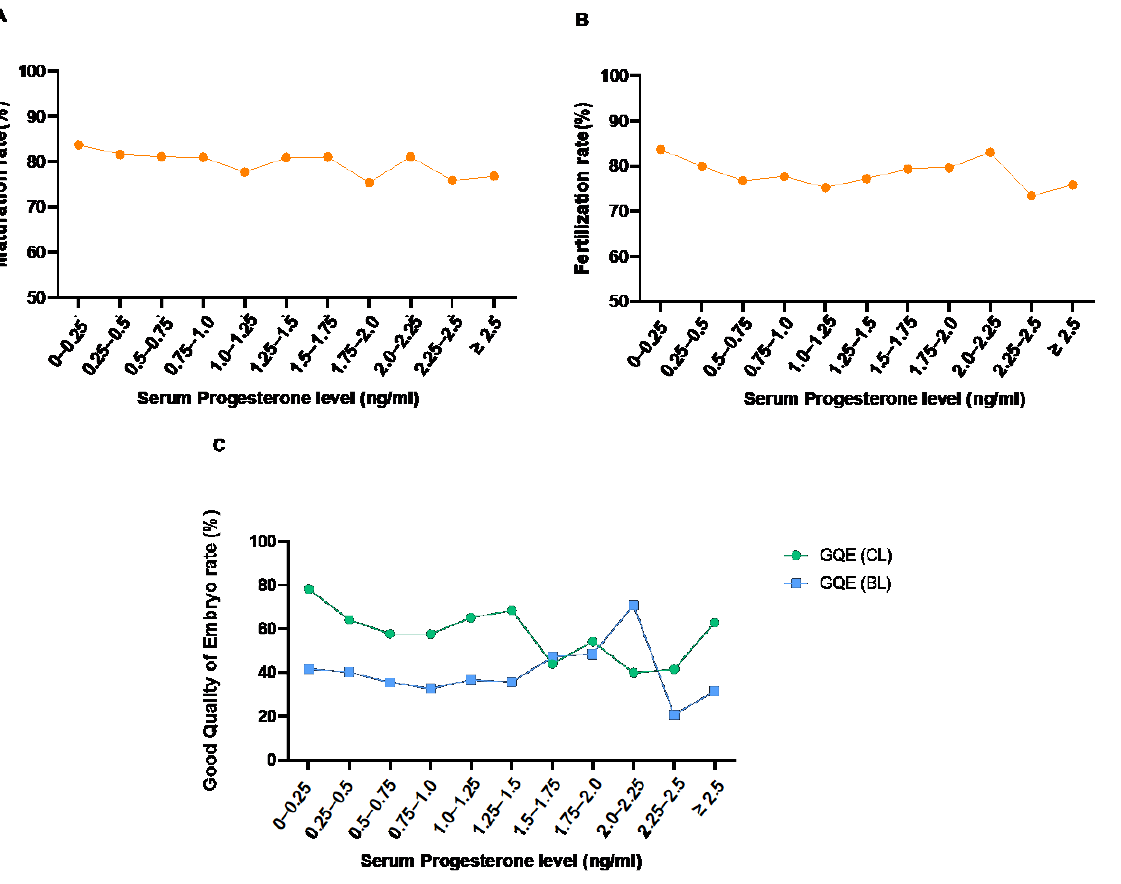
Figure 1. Association between the levels of serum progesterone on the day of hCG admin-istration and maturation rate ( A ), fertilization rate ( B ), and good-quality embryo (GQE) rate (cleavage stage (CL) and blastocyst stage (BL)) ( C ).